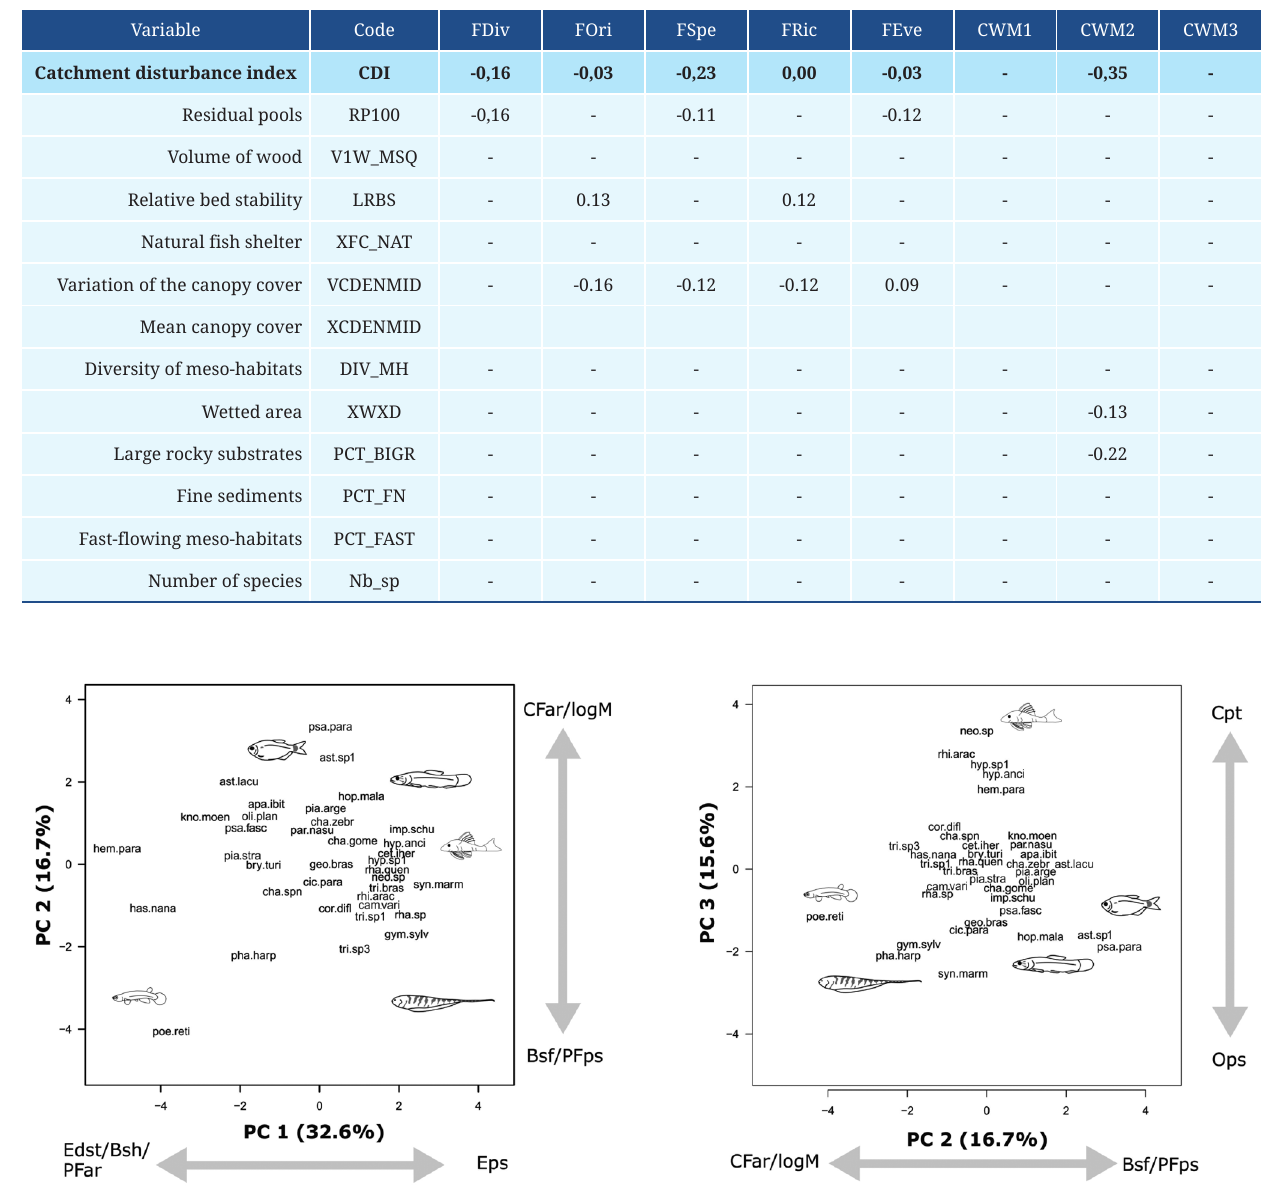
TABLE 3 | Total and indirect effects of catchment degradation (CDI), mediated by instream physical-habitat metrics, on the functional structure of the stream fish assemblages from the Araguari River basin. FDiv: functional divergence, FOri: functional originality, FSpe: functional specialization, FRic: functional richness, FEve: functional evenness, Nb_sp: number of species, CWM1-3: functional identity. The indirect effect of CDI on each functional index, mediated by instream physical habitat, is calculated by multiplying the standardized path coefficients (taking into account the signal, positive or negative) of the two significant direct effects linking them (arrows in Fig. 4): i) from CDI to a physical-habitat metric; ii) from that physical-habitat metric to the functional index. For instance, the indirect effect of CDI on FDiv via RP100 is -0.16 ((-0.39) * (+0.40)). The total effect of CDI on a given functional index is the sum of all significant indirect effects linking them. For instance, the total effect